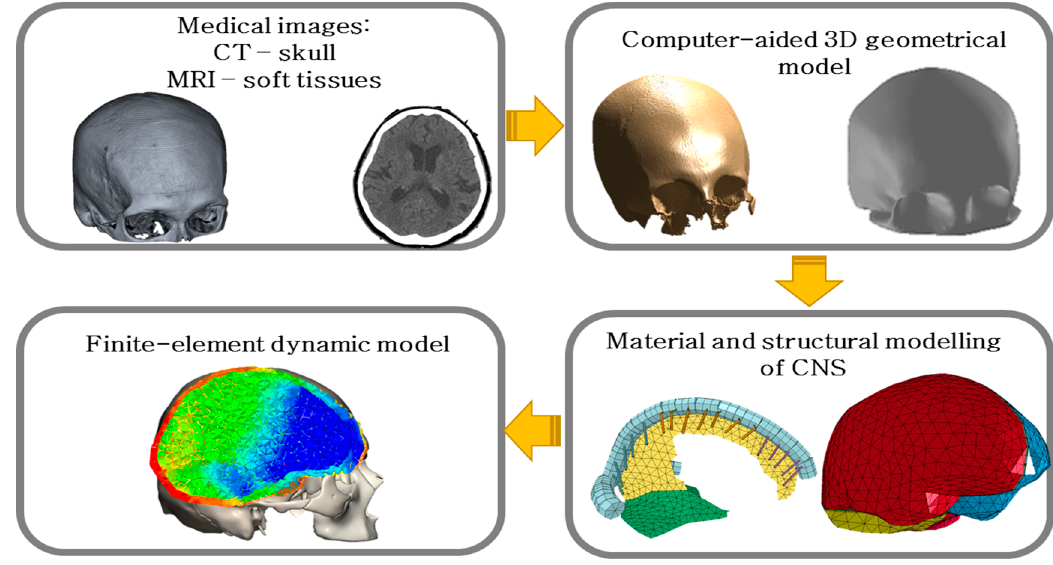
Figure 1. Procedure for creating a numerical model of the head.